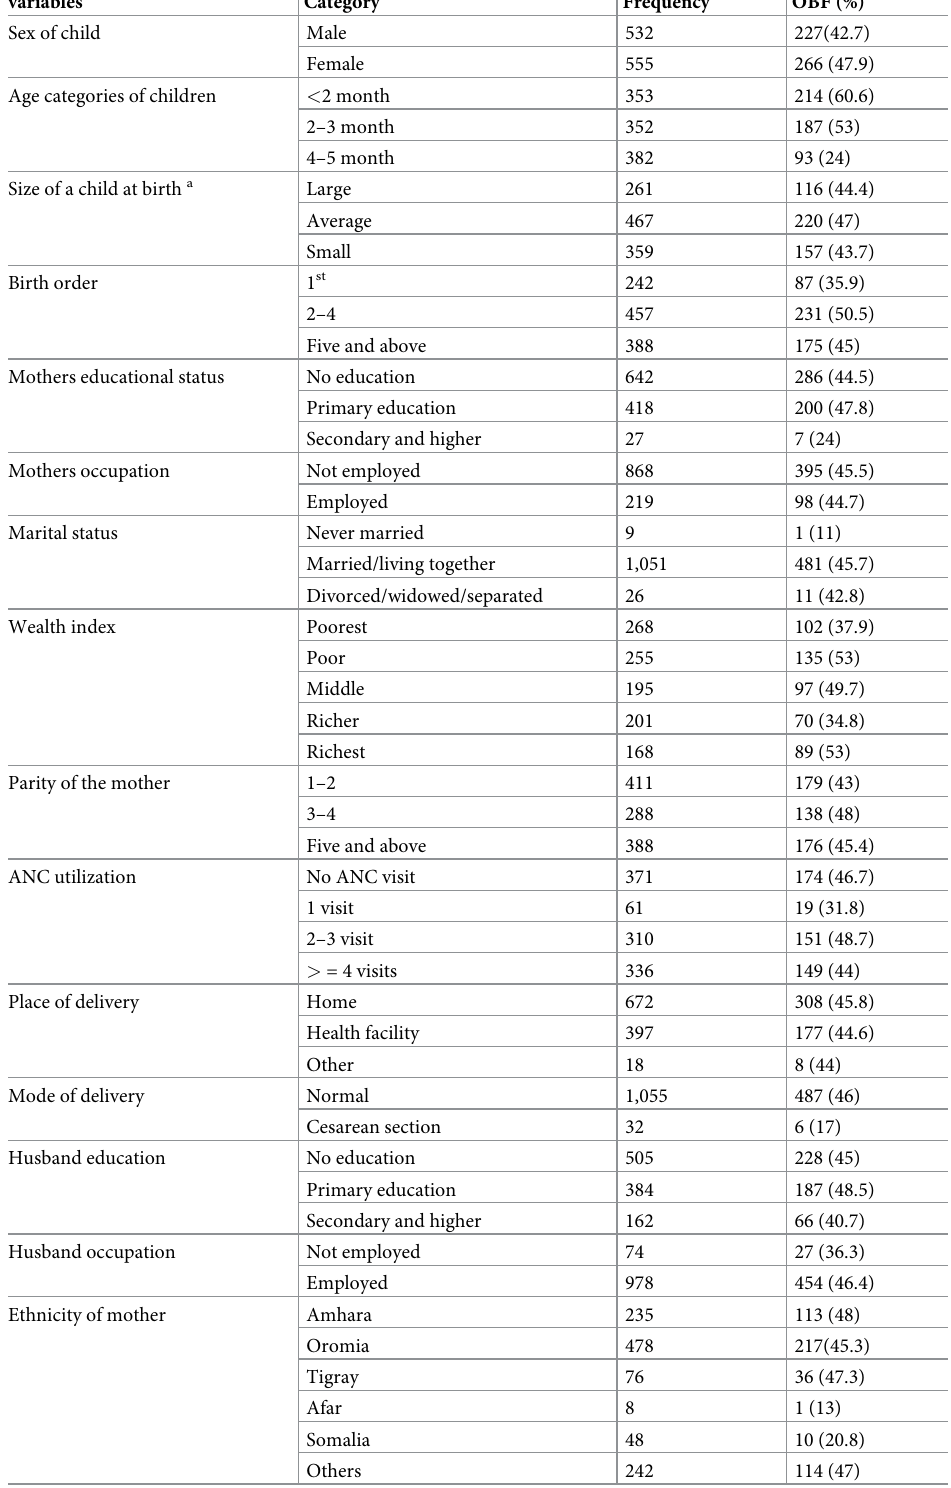
Table 2. Distribution of OBF with individual level variables among 0–5 month old children, Ethiopia 2016 (n =